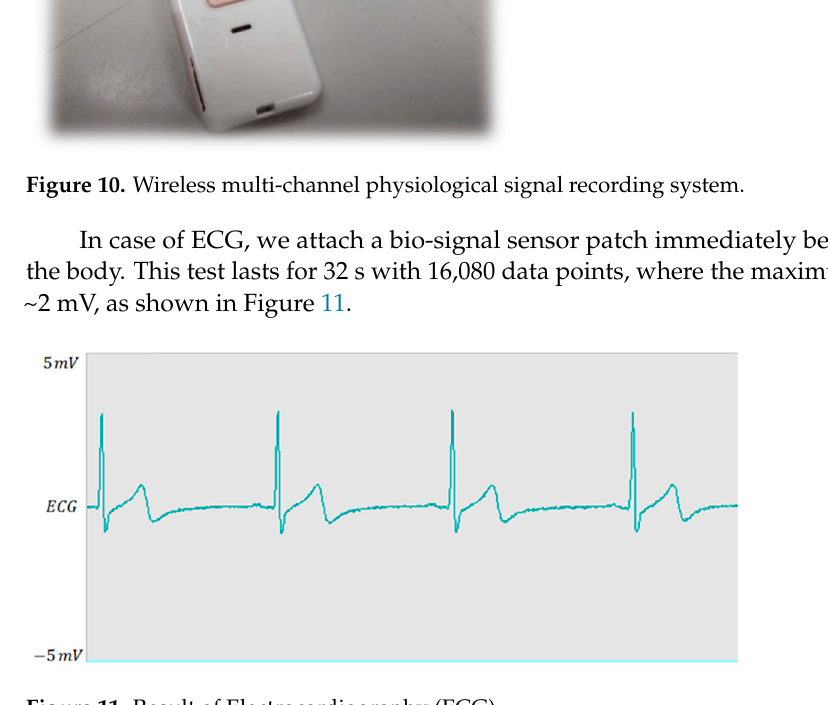
Figure 11. Result of Electrocardiography (ECG).